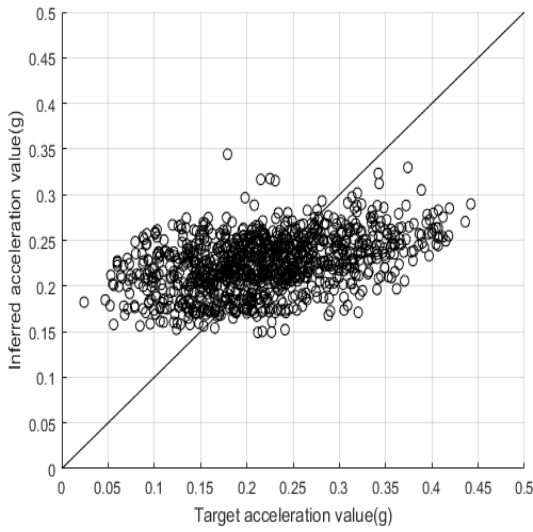
Figure 7. Test results of 4400 training samples for spectral-yield displacement 𝑆 𝑎𝑦 with 11 building